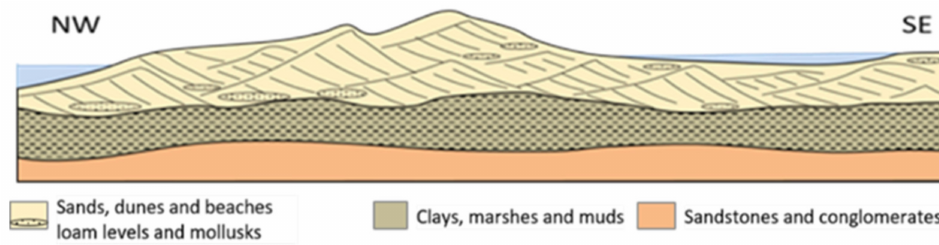
Figure 2. Synthetic section of the recent detrital materials of the study area.